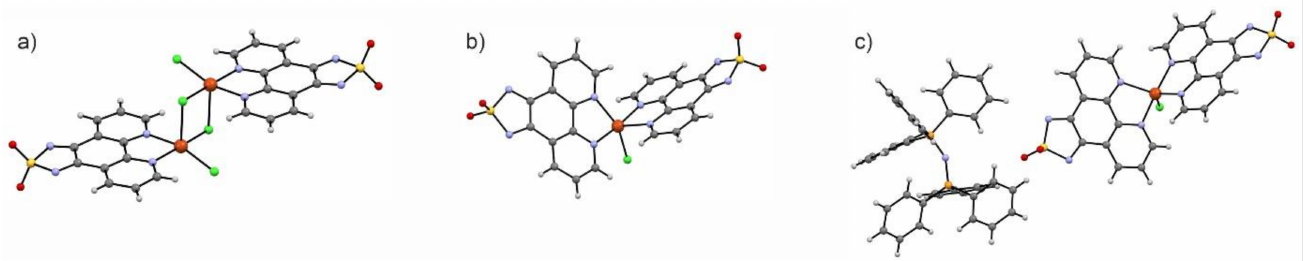
Figure 13. A family of Cu II -1,10-tdapO 2 complexes where the 1,10-tdapO 2 ligands exhibit different valence states: two neutral ligands in a Cu II 2 dimer ( a ), Cu II complex with one neutral and one radical anion ( b ) and a similar Cu II complex with two radical anions ( c )